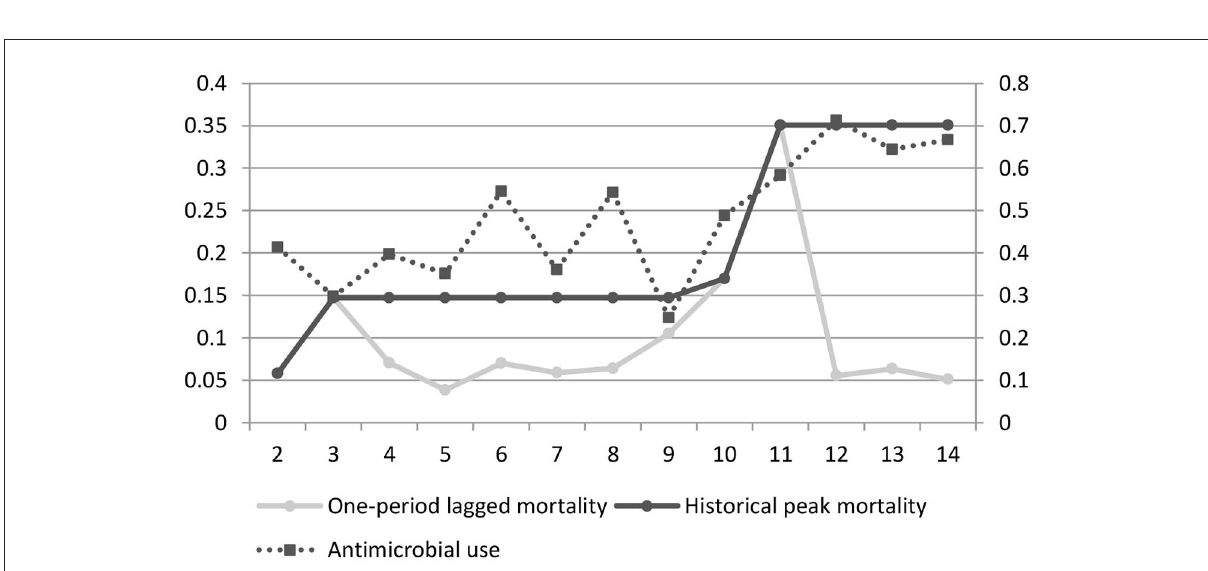
FIGURE2 Broiler mortality and current antibiotic use by an individual farmer. The horizontal axis represents batches of broilers, the left vertical axis represents the mortality, and the right vertical axis represents the cost of antibiotics per broiler (yuan/broiler).